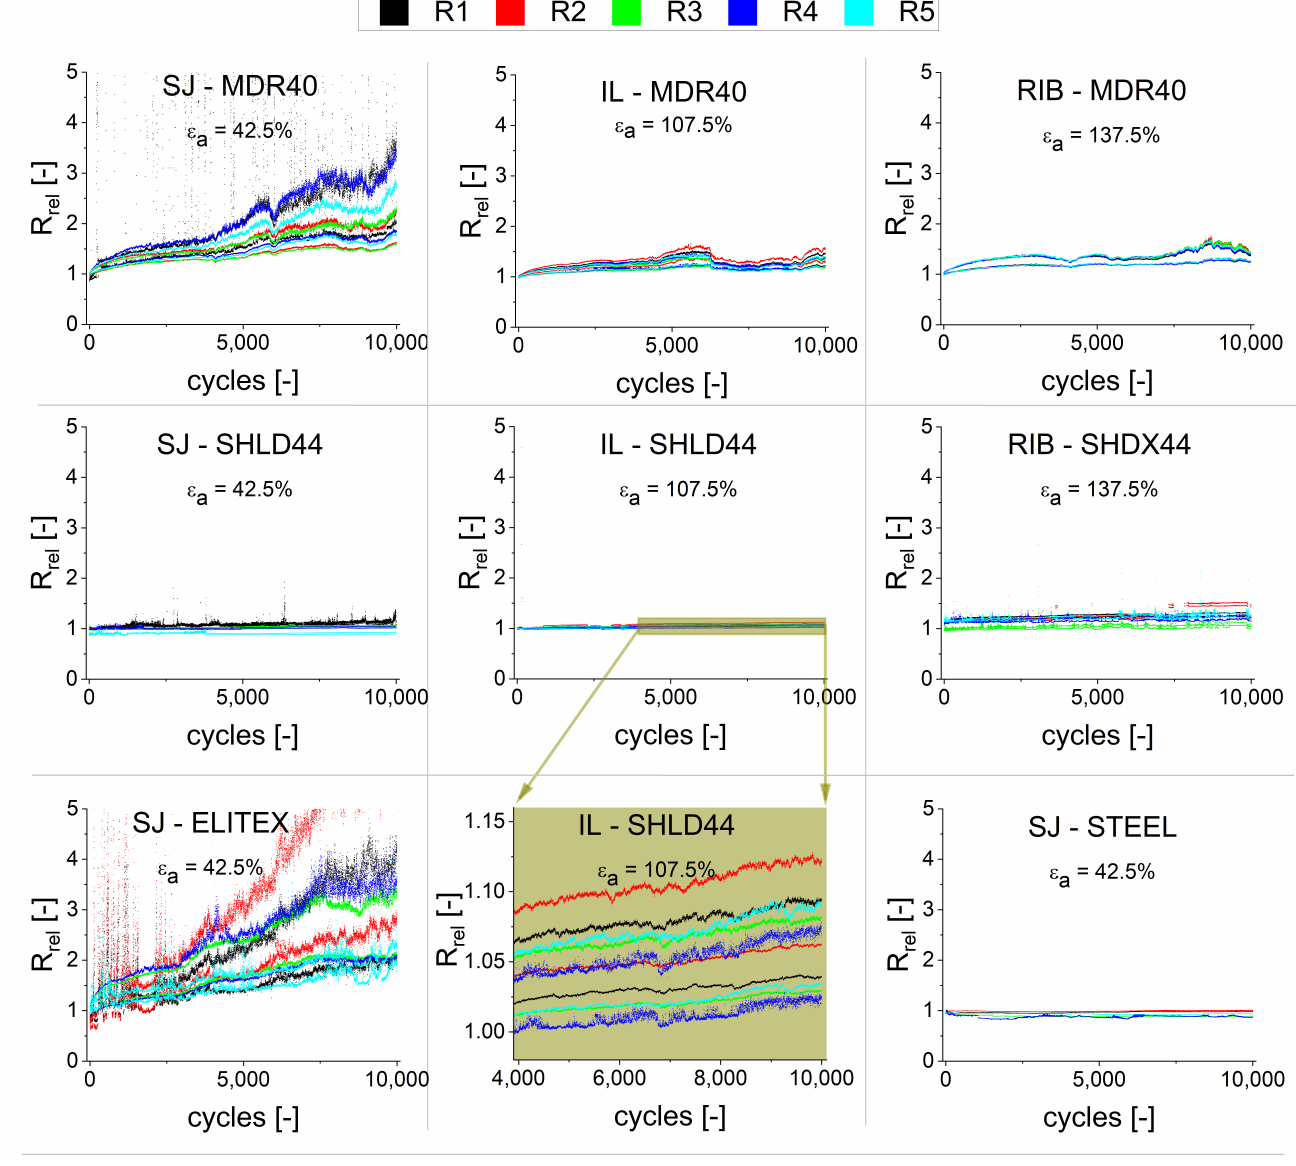
Figure 8. Relative change in resistance for different combinations after stretch